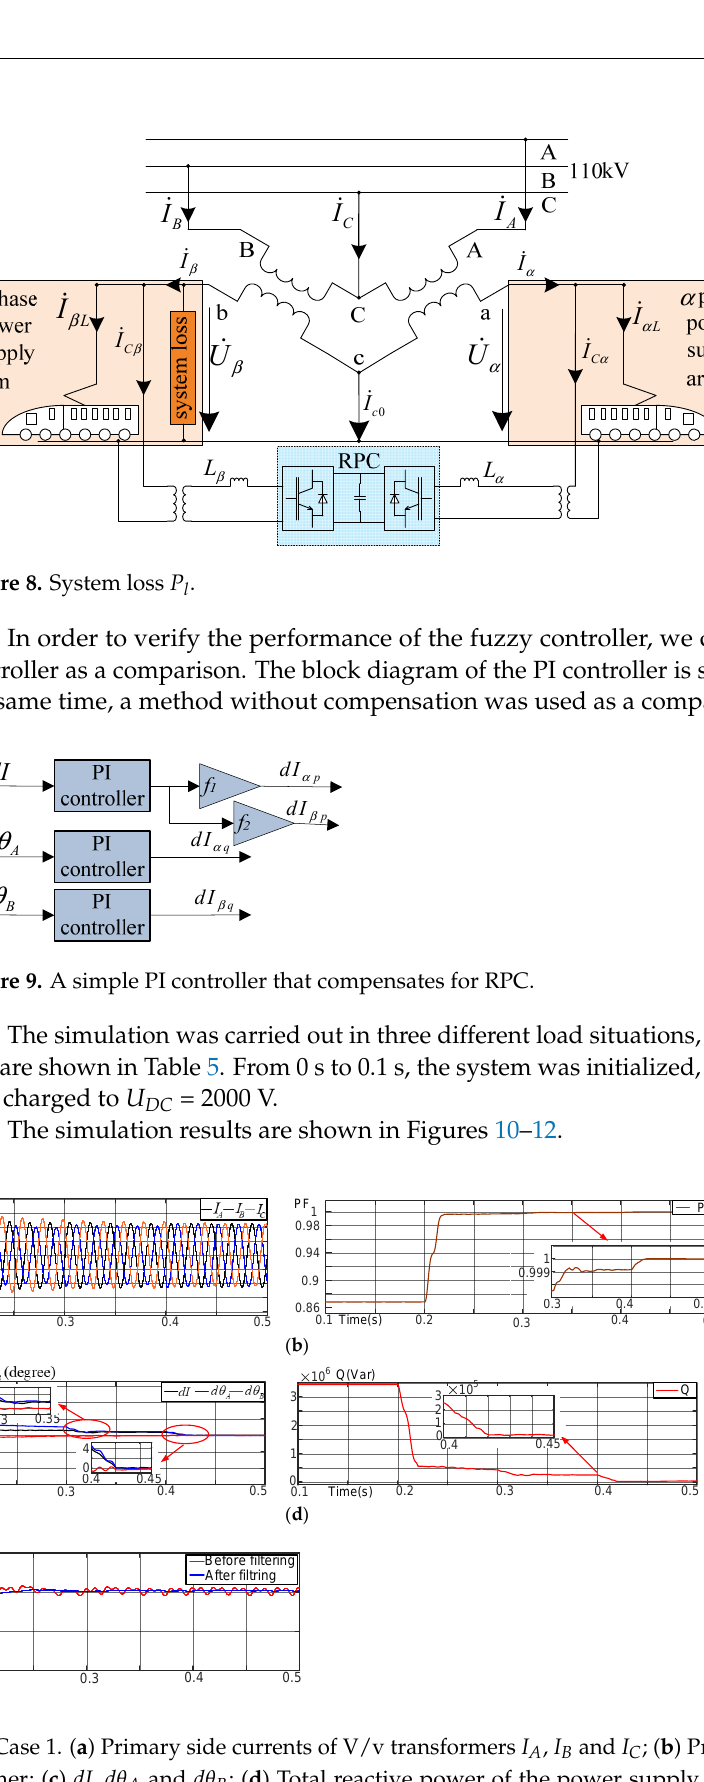
Figure 10. Simulation results of Case 1. ( a ) Primary side currents of V/v transformers I A , I B and I C ; ( b ) Primary side power factor (PF) of the V/v transformer; ( c ) dI , dθ A and dθ B ; ( d ) Total reactive power of the power supply system Q ; ( e ) DC capacitor voltage before and after filtering.